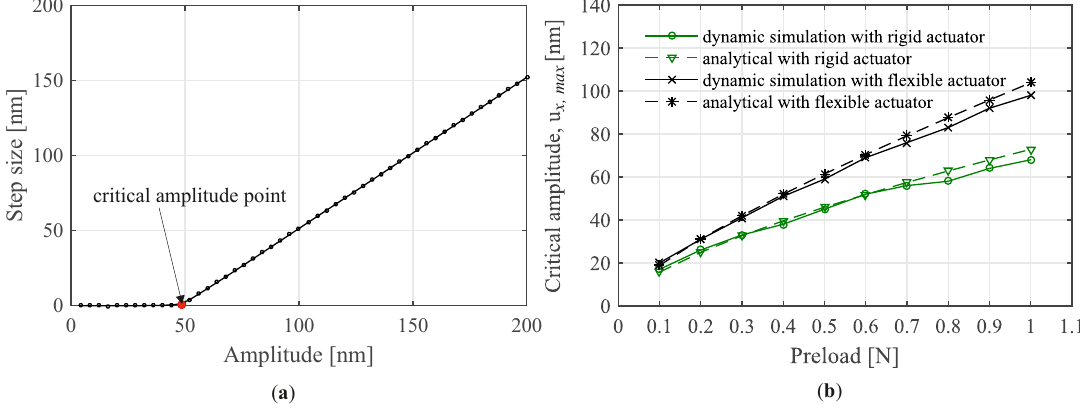
Figure 5. Simulations of the critical amplitude phenomenon using one-contact model: ( a ) dependency of the step size on the actuation amplitude; ( b ) dependency of the critical amplitude on the preload and its relation to u x , max